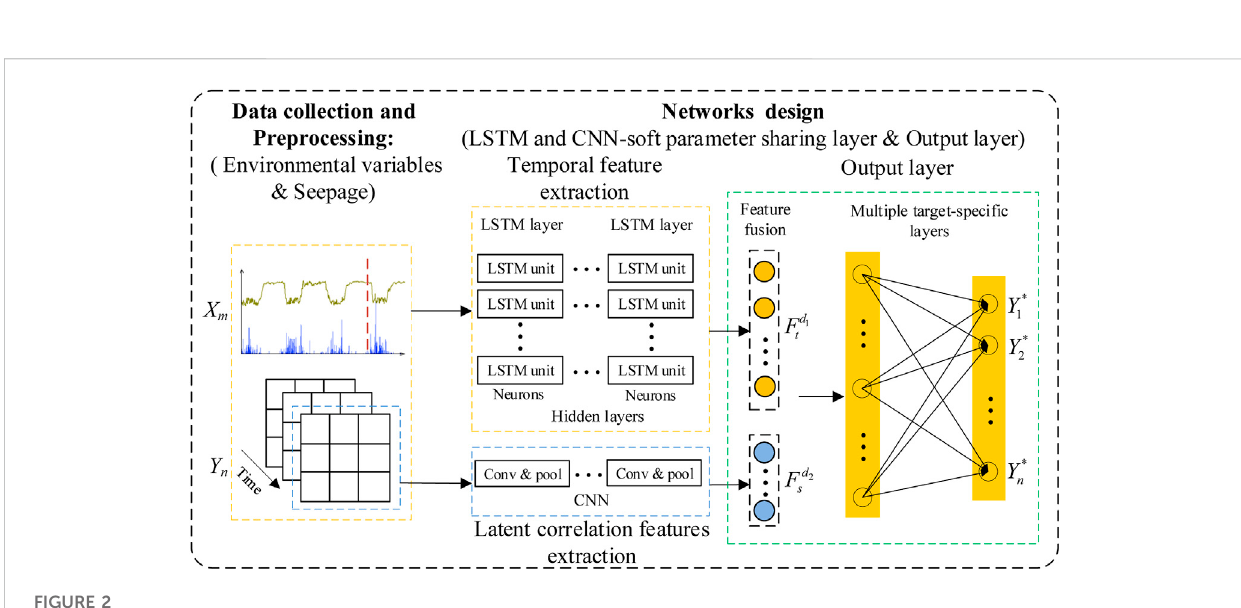
FIGURE 2 The framework of the MPM